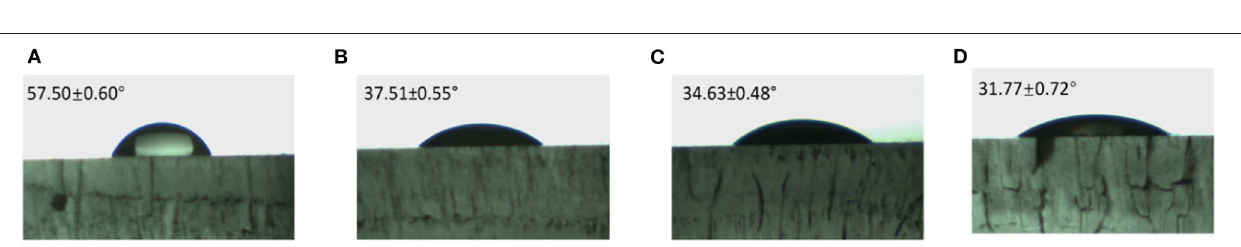
FIGURE 6 | Contact angle on glasses treated by oxygen plasma with different time. (A) Bare glass, (B) 1-min treatment, (C) 4-min treatment, (D) 8-min treatment.